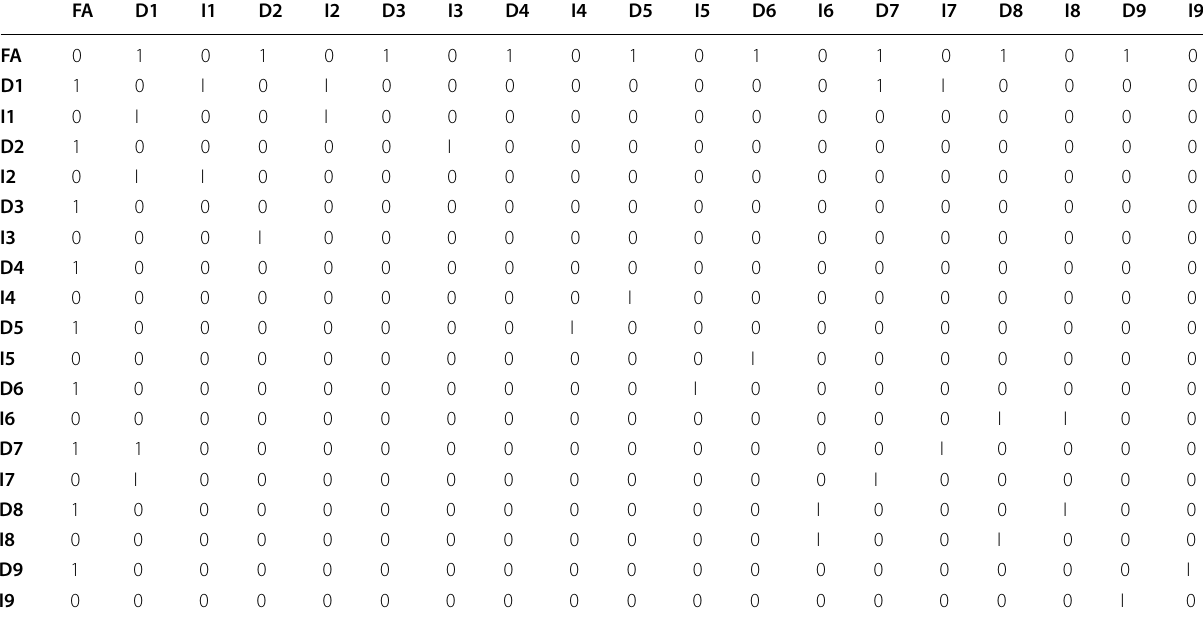
Table 5 Adjacency Matrix based on NCM